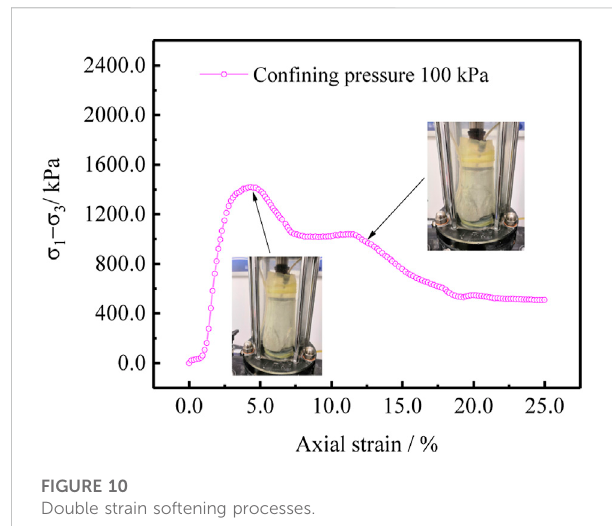
FIGURE 10 Double strain softening